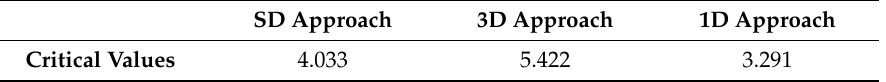
Table 2. Critical values of SD, 3D, and 1D test statistics.